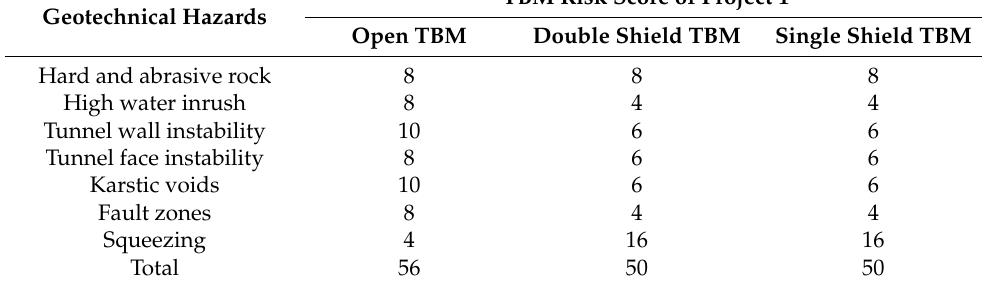
Table 22. TBM risk score of Project 1.